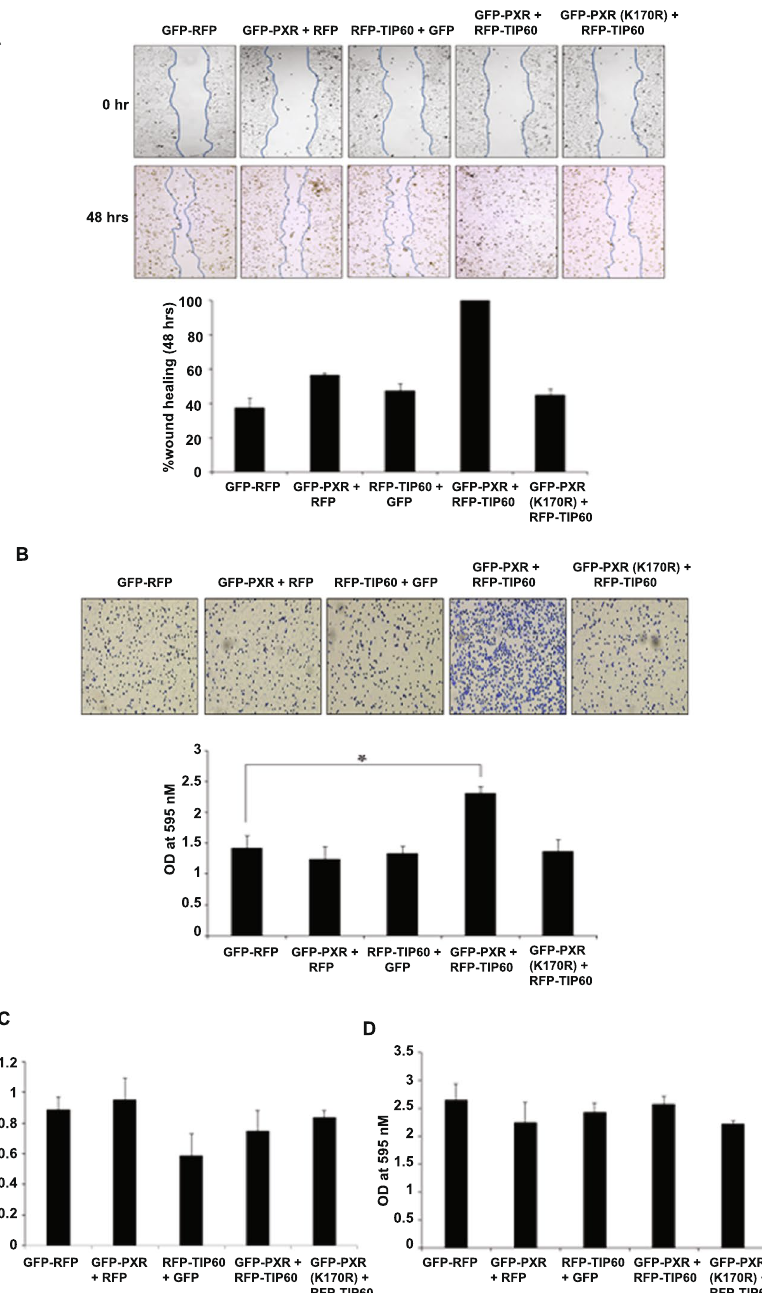
Figure 7. TIP60-PXR complex promotes cell migration and adhesion. ( A ) Wound-healing assay was performed in HepG2 cells transfected with different plasmids in different combinations as indicated in the figure. Scratch was generated with a sterile pipette tip in the transfected cells monolayer and the wound gap closure was monitored by capturing images at different time intervals and the graph was plotted for the obtained values of wound healing at 48 hrs. ( B ) To check the effect of TIP60-PXR complex on cell adhesion, HepG2 cells were transfected with indicated plasmids and equal numbers of cells were seeded for adherence. Adhered cells were stained with crystal violet and images were taken followed by cell lysis with SDS and the absorbance was measured at 595 nM. Graph was plotted for the average value of three independent experiments with ± SD. Asterisk shows P value < 0.005. ( C ) For examining the effect of TIP60-PXR complex on cell invasion, HepG2 cells were transfected with indicated plasmids and equal numbers of cells were seeded on geltrex coated transwell filled with 10% FBS medium in the bottom chamber. After 12 hrs cells migrated on the lower surface of the membrane were stained using crystal violet and lysed with SDS. Absorbance was measured at 595 nM and graph was plotted for the average value of three independent experiments done in duplicate with ± SD. ( D ) For cell proliferation assay, HepG2 cells were transfected with plasmids as indicated and equal number of cells were seeded. After 6–7 days cells were stained with crystal violet and lysed with SDS followed by absorbance measurement at 595 nM. Average value of three independent experiments was used to plot the graph with ±